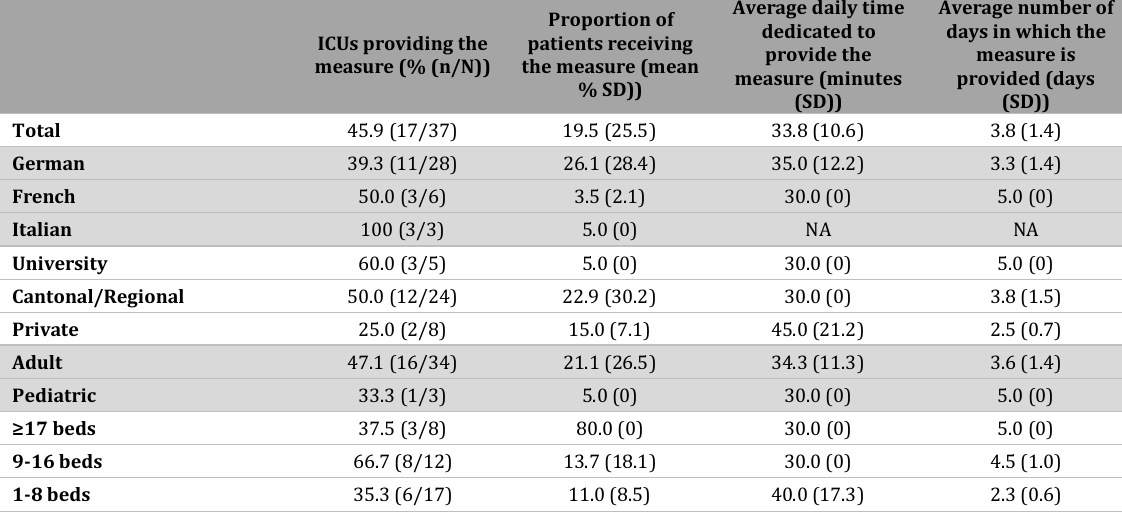
Table S16. Active resistance exercises, bedside cycling